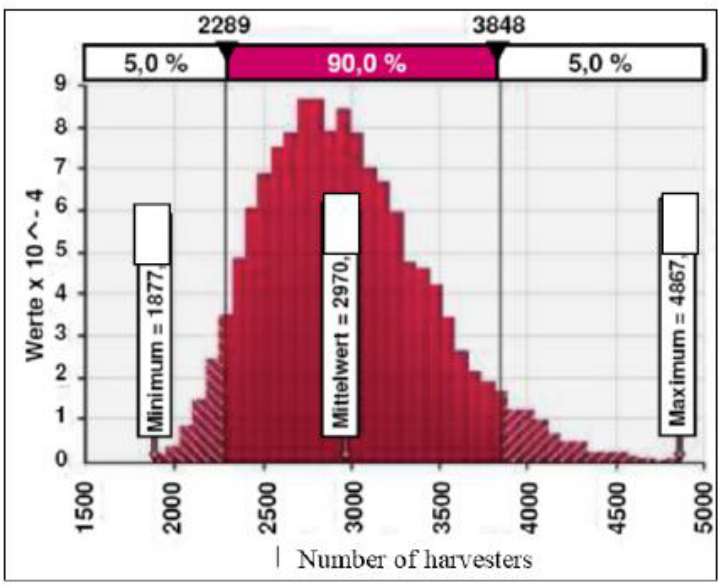
Figure 6. Distribution of the necessary number of harvesters in the threshing region